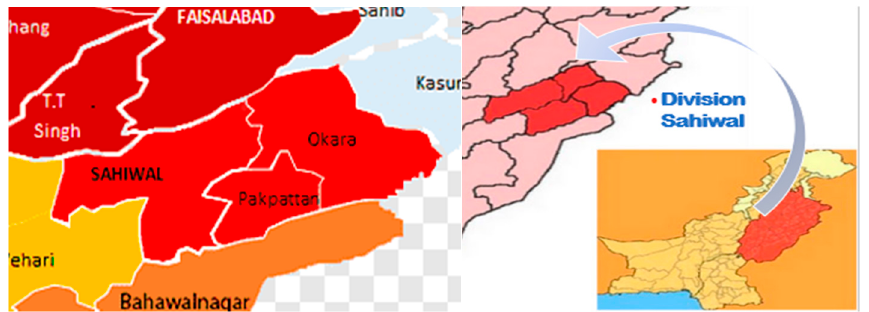
Figure 2. Sahiwal division on a map of Pakistan.